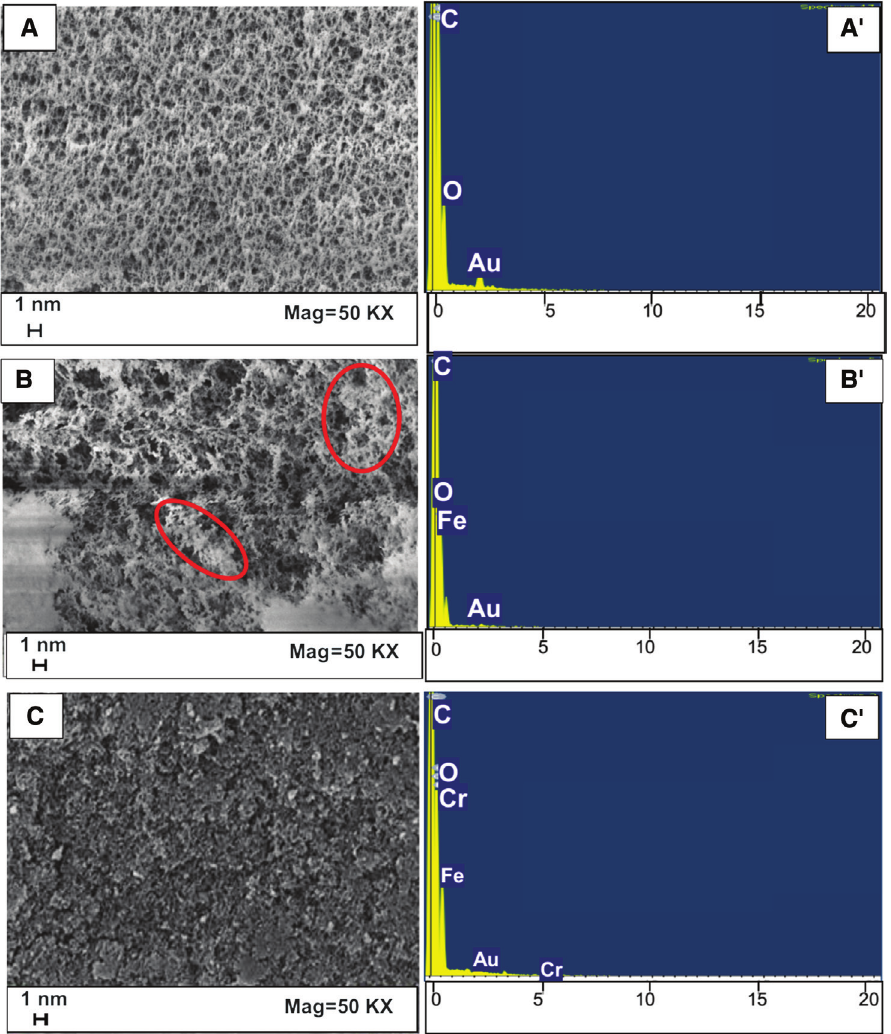
Figure 4 SEM and EDX spectra of different samples: (A, A ′ ) RF-AG, (B, B ′ ) Fe-RF-AG, and (C, C ′ ) Cr(VI)-adsorbed Fe-RF-AG.